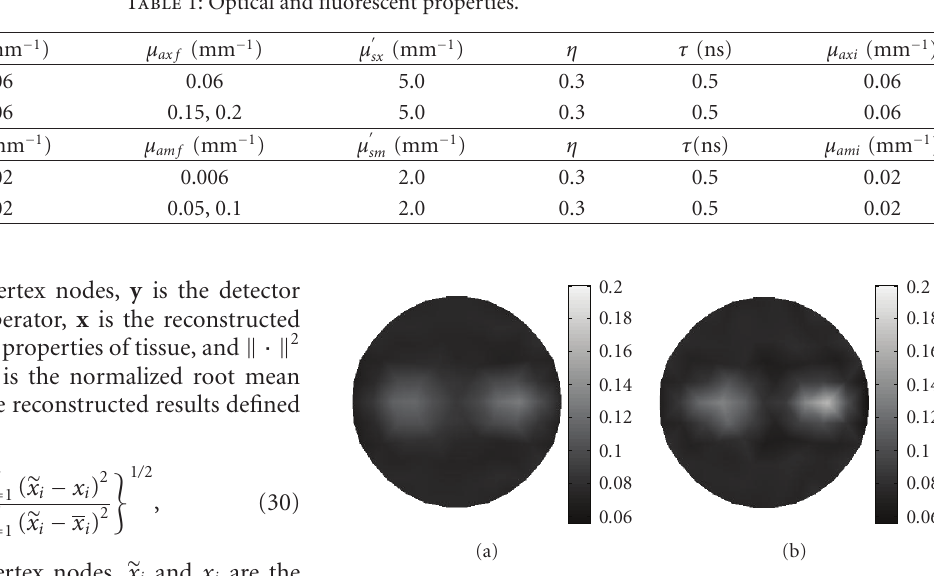
Figure 3: Reconstructed image of absorption coe ffi cient due to fluorophore μ axf (a) without data correction, and (b) with data correction.